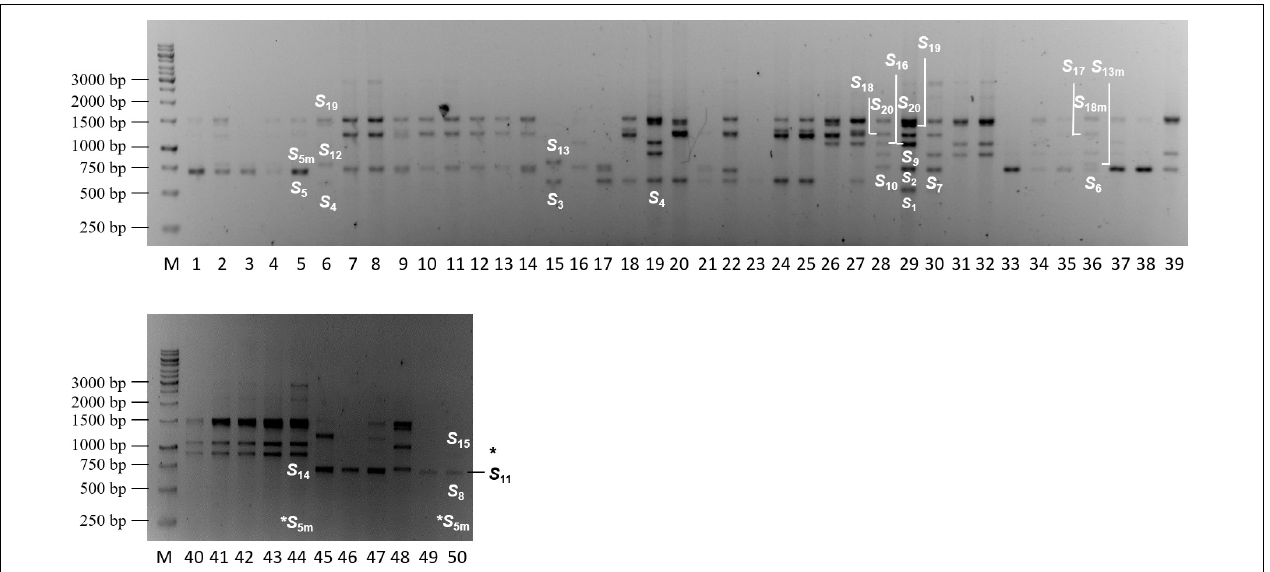
FIGURE 1 | Agarose gel showing amplification products of PCR analysis conducted using the PaConsII-F and PaConsII-R consensus primers amplifying the second intron of the Prunus laurocerasus S-RNase gene. M: GeneRuler 1kb DNA Ladder (Thermo Fisher Scientific), 1–50: Prunus laurocerasus accessions; black asterisk indicates a faint but visible band, white asterisks show alleles determined by sequencing but not detected on the gel.